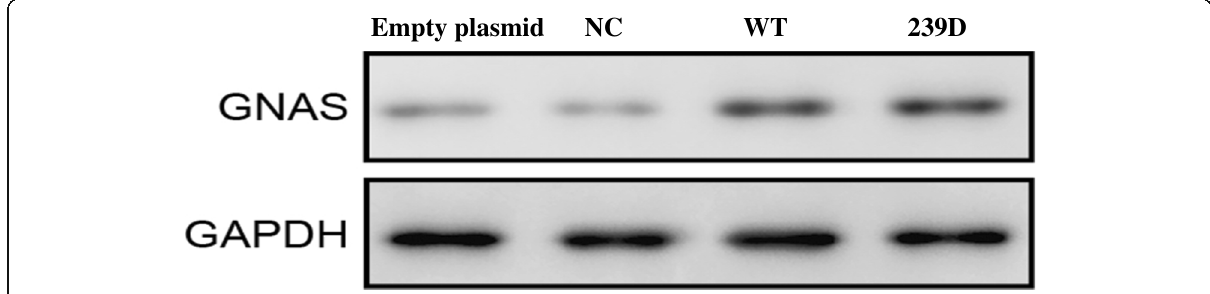
Fig. 4 Comparison of Gs α -protein levels in OK cells transfected with WT or mutant GNAS constructs by western blot analysis. Cells transfected with the empty plasmid vector (pcDNA3.1) and non-transfected control (NC) were used as controls. The bands were blotted with anti-GNAS antibody. GAPDH was used as an internal control. The protein expression of the mutant Gs α -239D was similar to that the WT